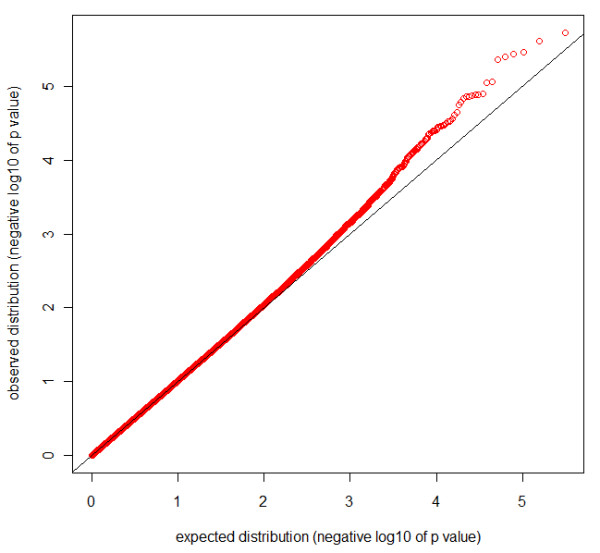
P-P plot of SNP level results. p values of correlation among couples are plotted for all SNPs as a function of the normal distribution. The black line is equal to the expectation on H0. Overall, the data follows the normal distribution with an excess in the tail at p < 10-4.